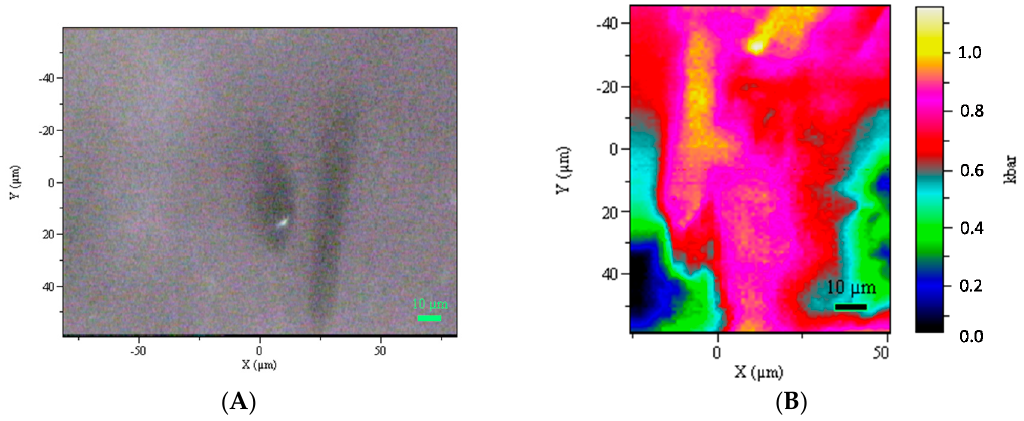
Figure 12. Photomicrograph of measured rutile inclusions within the ruby host ( A ); Raman map showing the shift of R-lines in laser-induced photoluminescence spectra expressed in pressure (in kbar) around rutile inclusions within the ruby host ( B ).